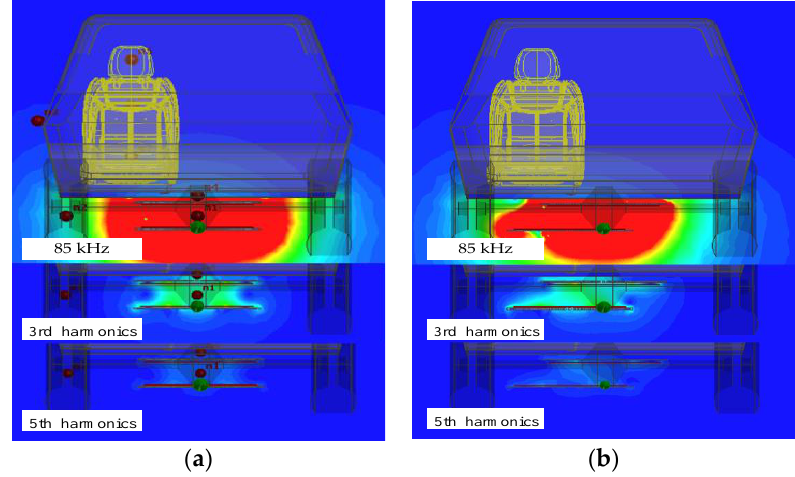
Figure 19. Comparison of different magnetic field: ( a ) alignment; ( b ) 30% offset.